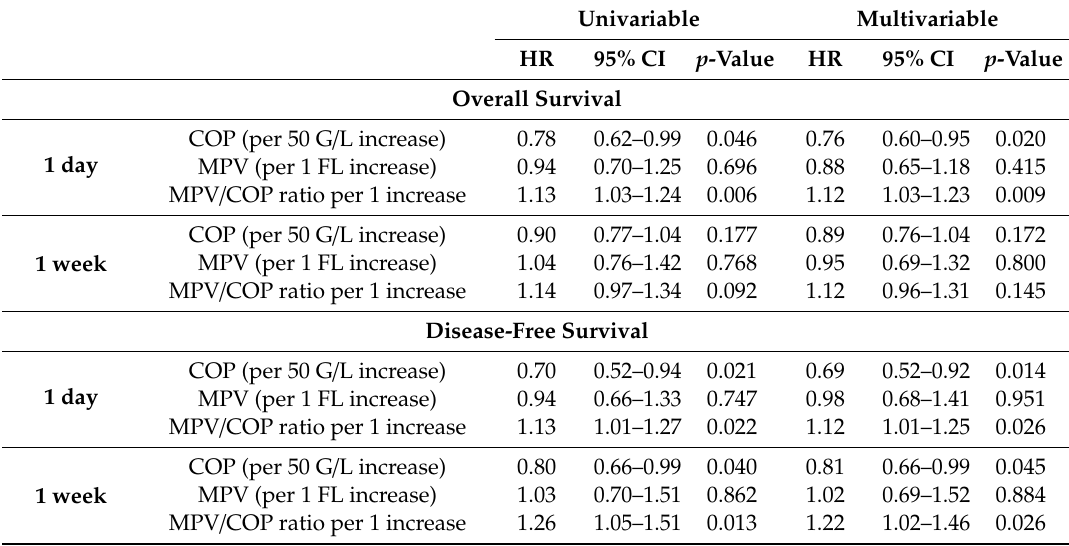
Table 2. Postoperative platelet indices: Univariable and multivariable time-to-event analysis. Univariable Multivariable HR 95% CI p